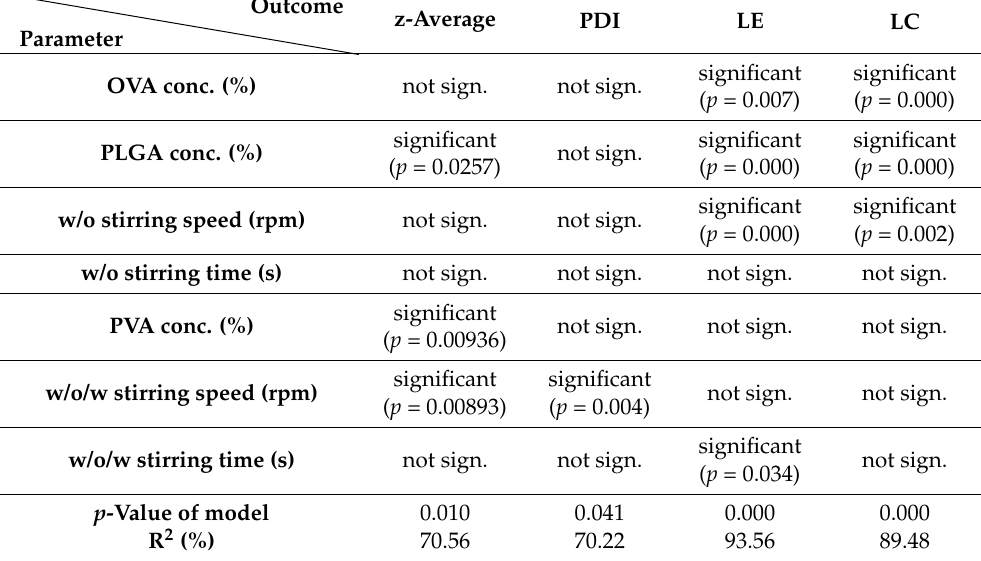
Table 3. Significance of parameters on responses and model